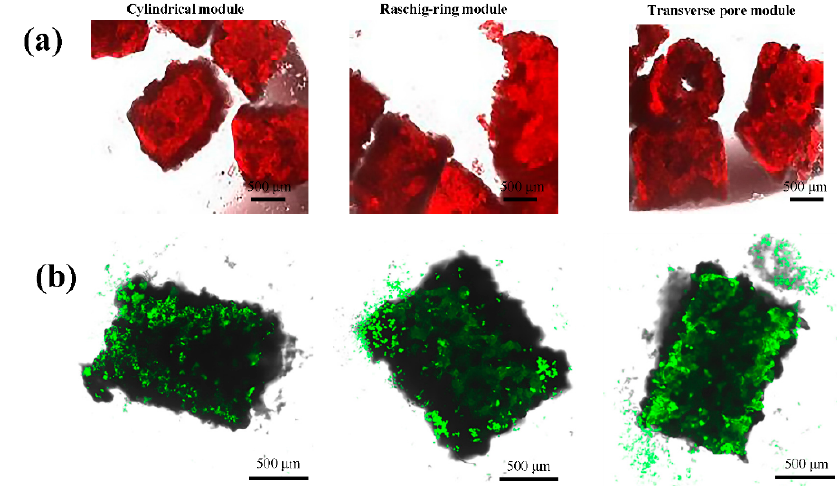
Figure 5. Confocal images of ( a ) PKH-labeled Hep G2 cells and ( b ) calcein AM–stained live cells on day 10 of culturing.